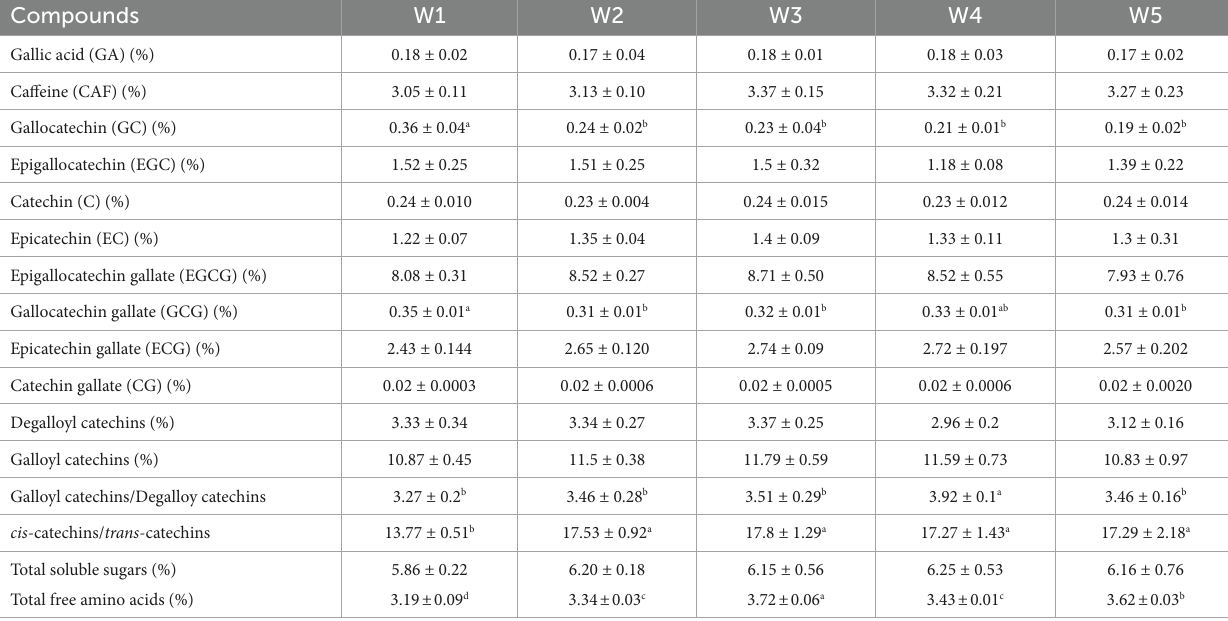
TABLE 1 Contents of major chemical constituents in Longjing tea samples with different withering degrees, including gallic acid, caffeine, catechins, total amino acids and total soluble sugars. Compounds W1